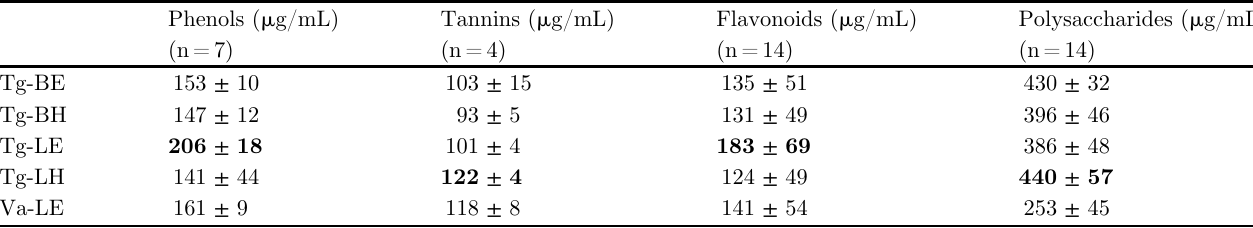
Table 1. Phytochemical screening of the plant extracts. Phenols ( m g/mL)